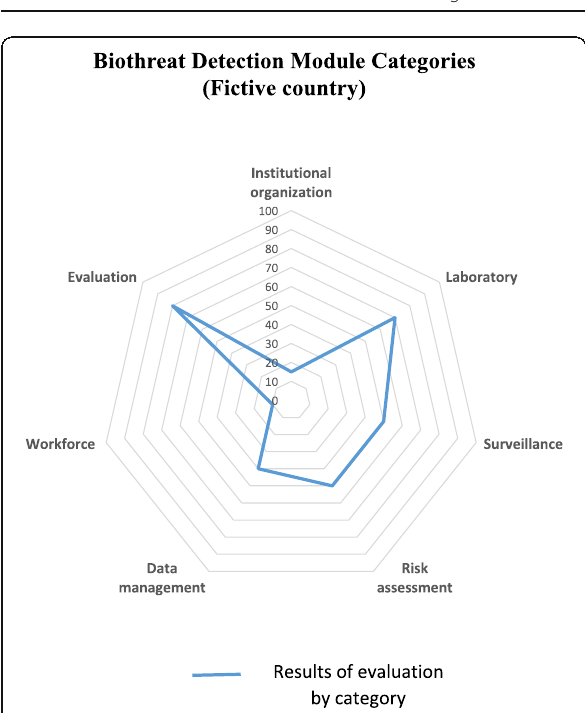
Fig. 3 Example of graphical output of the FAO SET Biothreat Detection Module using figurative results of a fictive country. The spider graph shows results by SET Biothreat Detection Module category of a fictive country. Each of the 7 SET Biothreat Detection Module categories form an individual axis whose value varies from 0 to 100%. The blue line shows the results for the SET Biothreat Detection Module from 0 to 100%. The closer the line is positioned to the outer border of the graph, the higher the capacity of the country in the respective category and